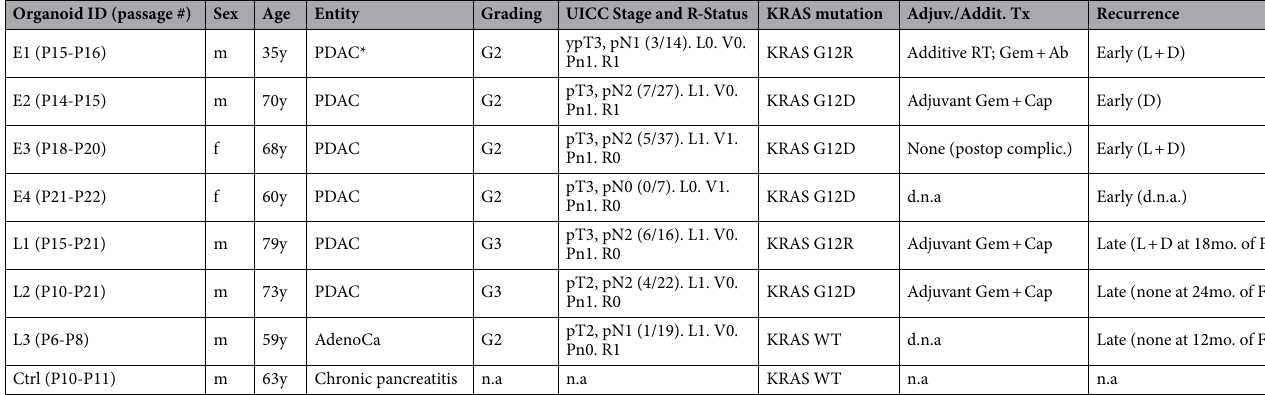
Table 2. Clinicopathological data of patients who provided tissue for patient-derived organoid cultures (PDO) used in this study. n.a. : not applicable; d.n.a. : data not available. *Neoadjuvant therapy w/ 3 cycles FOLFIRINOX and insufficient response; RT : radiotherapy; Gem : gemcitabine; Ab : nab-Paclitaxel; Cap : capecitabine; Early : tumor recurrence within the first 6 months after curatively intended resection; Late : no tumor recurrence even 12 months after resection; L : local recurrence, D : distant recurrence (hepatic/pulmonal/ peritoneal carcinomatosis); FU :